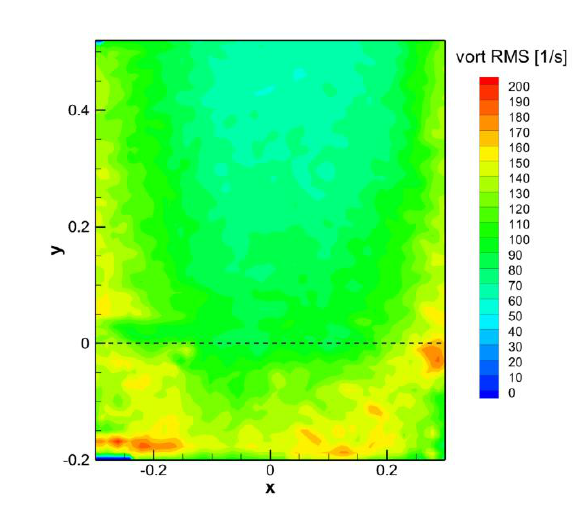
Fig. 15. RMS vorticity distribution. Re = 1M.